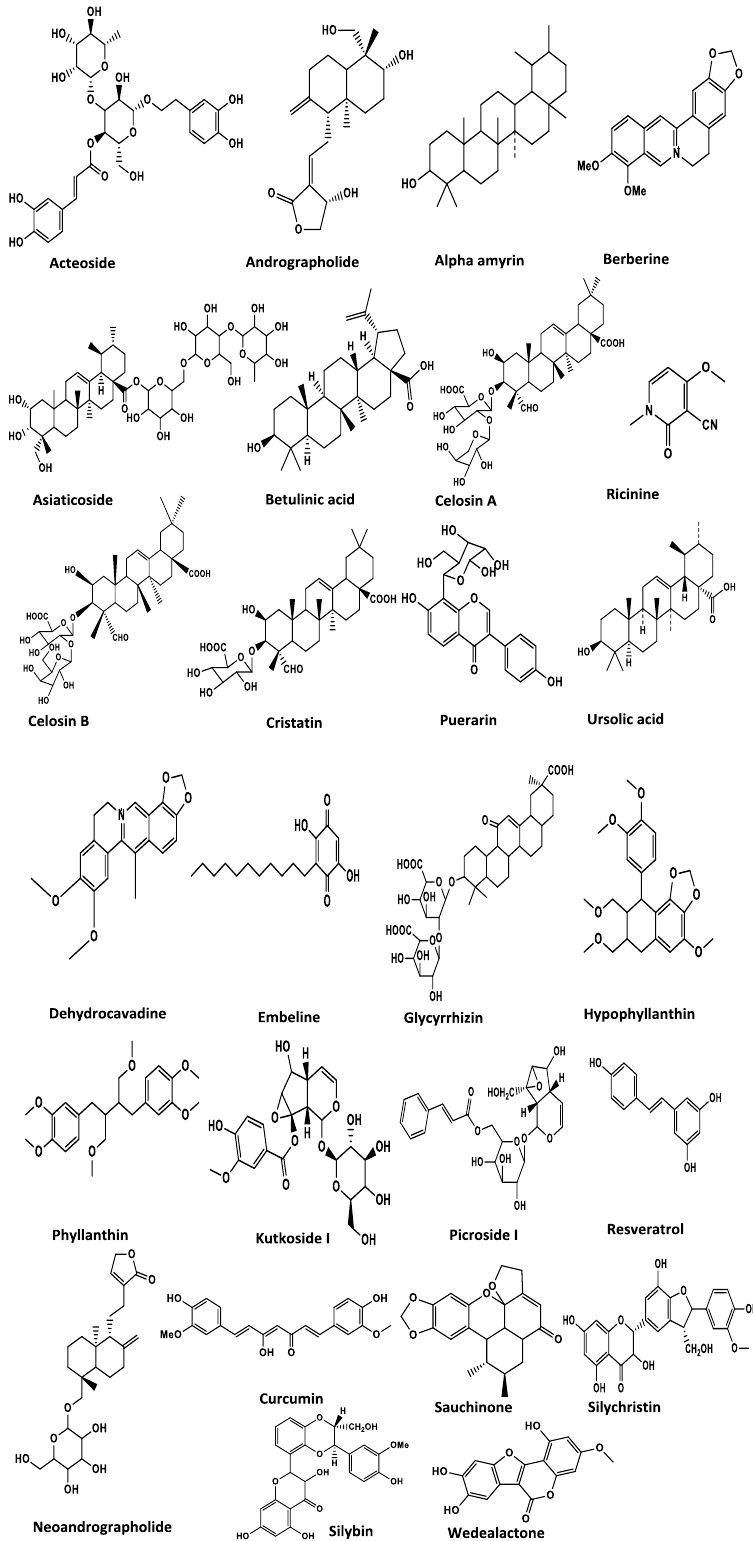
Fig. 1 Chemical structure of some potent bioactive phytochemical with hepatoprotective